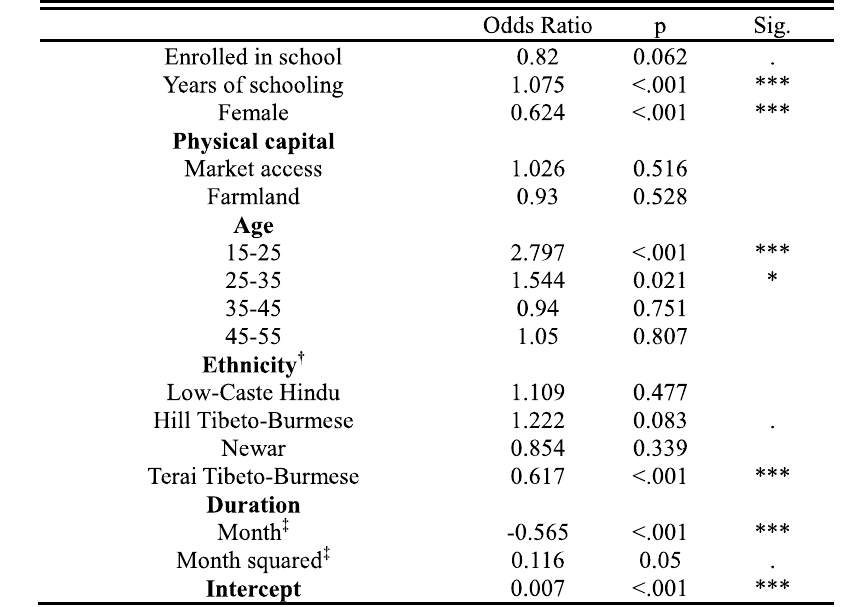
Table A1.4: Model of local-distant migration (following the work of Massey et al. 2010). Odds-ratios are from a discrete time event history analysis predicting monthly hazard of making a move outside of the Chitwan Valley. Two sided P-values. Significance is coded as: for P < 0.1, * for P < .05, ** for P < 0.01, *** for P < 0.001. The odds-ratios for ethnicity are relative to Upper-caste Hindus. For month and month-squared coefficients are listed rather than odds ratios as for these two covariates odds ratios are not directly interpretable (e.g. month cannot be held constant without varying